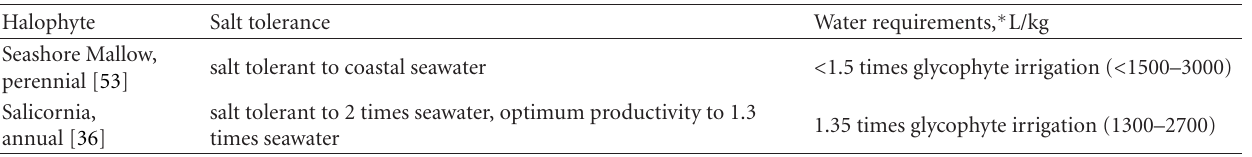
Figure 2: Malvaceae family [8–10] with halophyte seashore mallow (kosteletzkya virginica). Table 3: Halophyte water requirements and salt